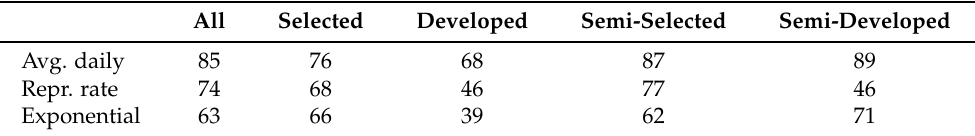
Table 6. Accuracy (%) achieved by the AdaBoost model, which often (but not always) performed the best for different data subsets (All, Selected, Developed, Semi-selected, Semi-developed). All Selected Developed Semi-Selected Semi-Developed Avg. daily 85 76 68 87 89 Repr. rate 74 68 46 77 46 Exponential 63 66 39 62